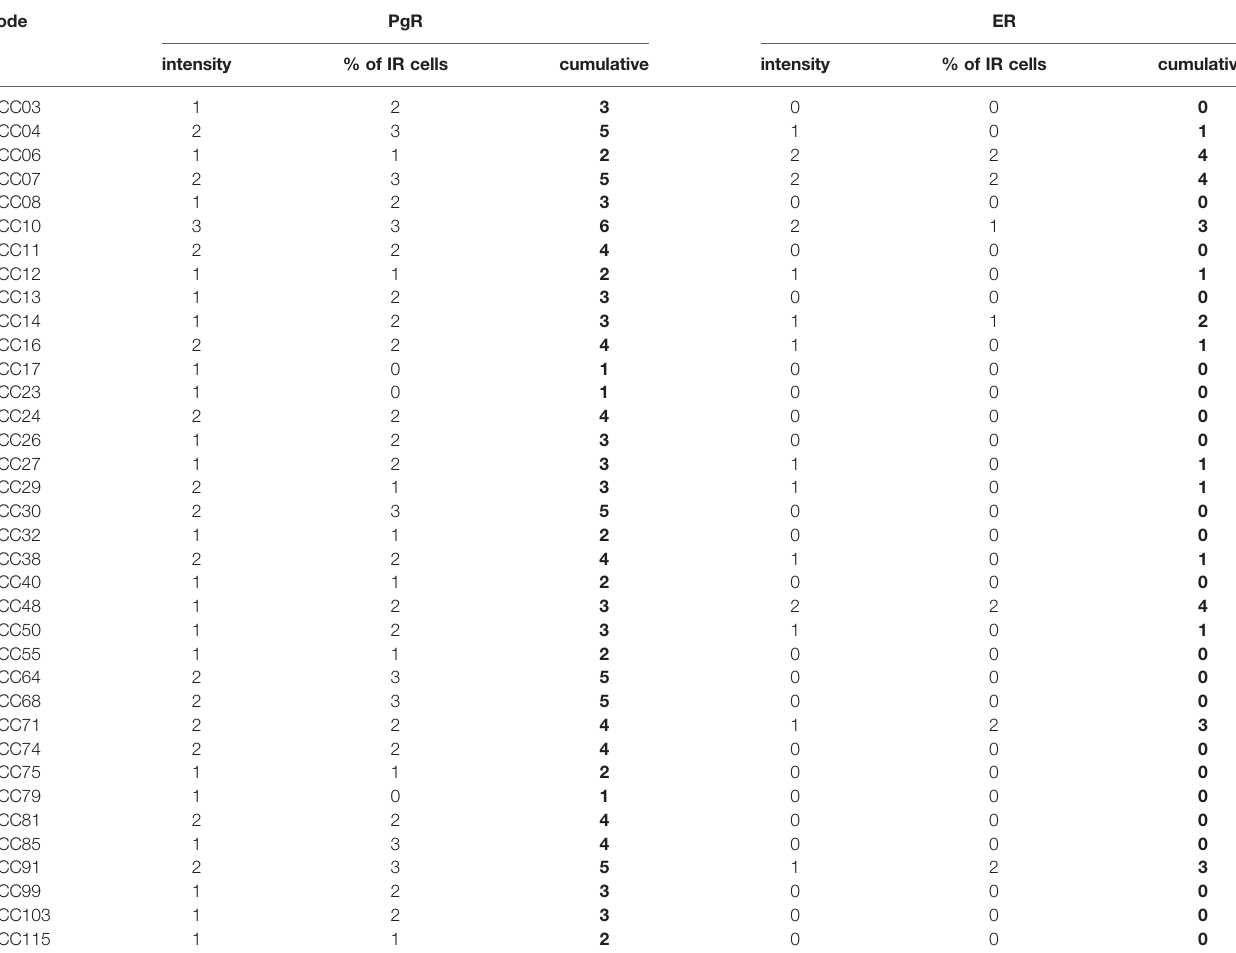
TABLE 2 | Histological features and expression of PgR and ER in ACC tumor specimens.